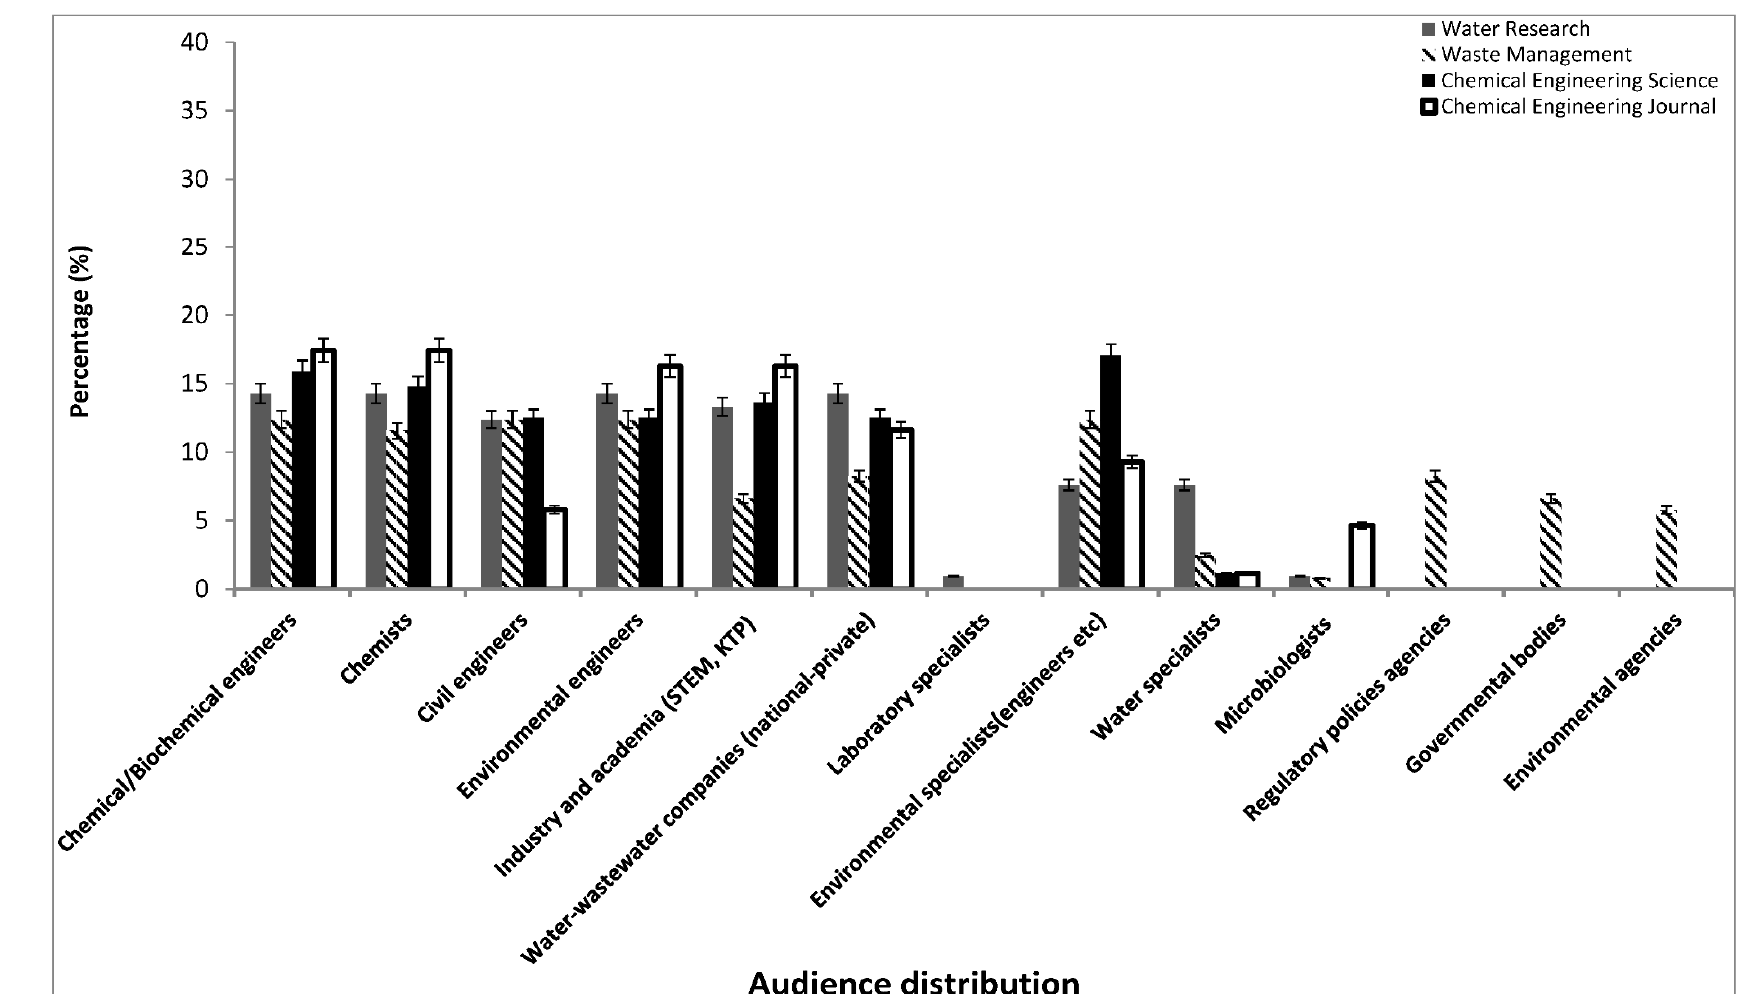
Figure 4. Distribution of potential types of audience of the analysed published manuscripts.